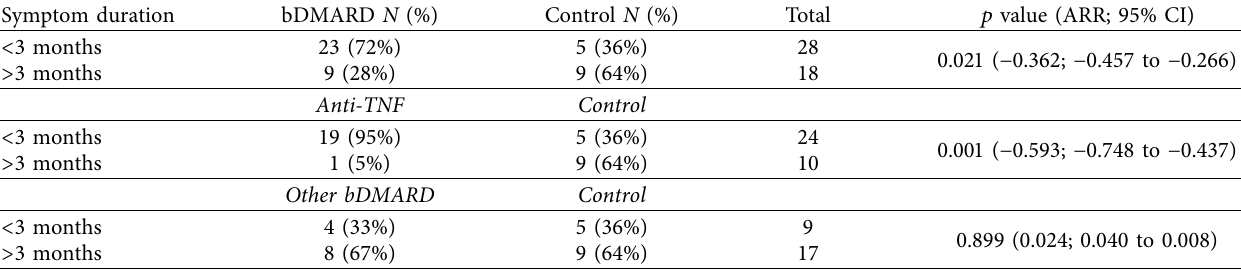
Table 2: Duration of CHIK symptoms comparing patients with positive IgG using biological DMARDs with the controls and comparing anti-TNF biologicals with other bDMARDs.